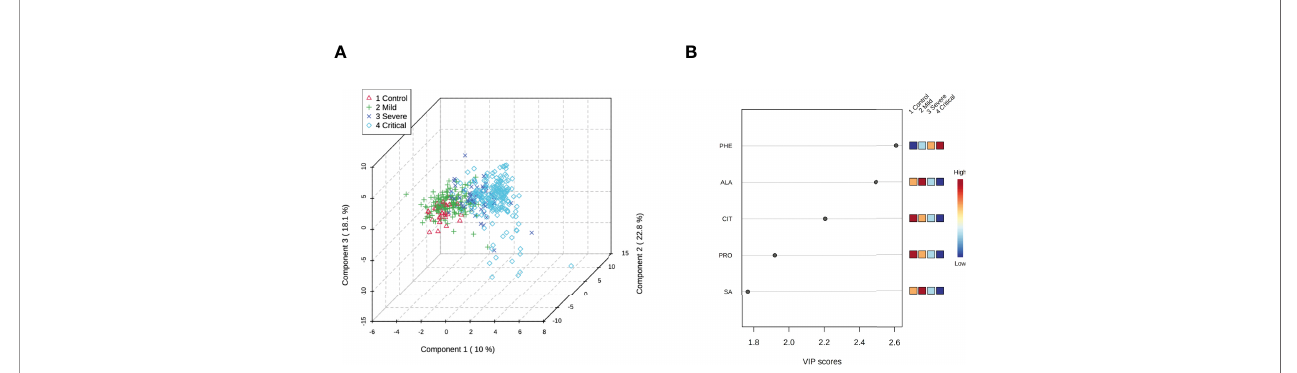
FIGURE 2 | Three-dimensional score plot of selected components. (A) Partial least squares-discriminant analysis plot of differential metabolites from HS and patients with mild, severe, and critical COVID-19. The explained variances are shown in parentheses. (B) Metabolites with a variable importance in projection (VIP) score >1.5. The intensities of colors in boxes to the right (from blue to red) indicate the relative concentrations of the corresponding metabolite in each group under study. HS= healthy subjects. PHE, Phenylalanine; ALA, Alanine; CIT, Citrulline; PRO, Proline; SA, succinylacetone.